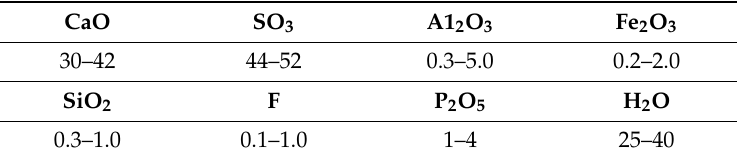
Table 2. Composition of phosphogypsum in terms of oxides, % [11].